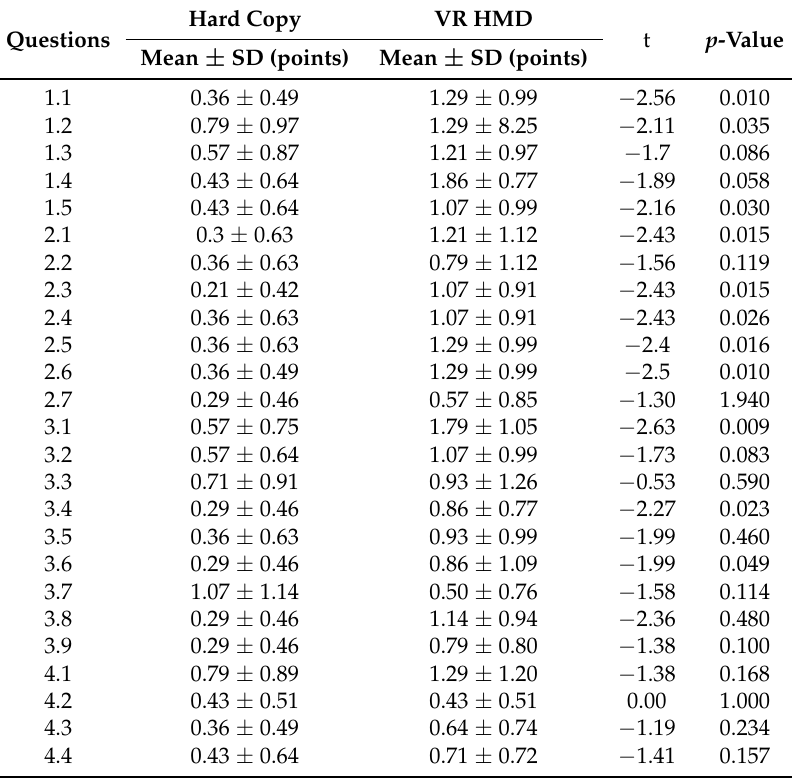
Table 4. Subjective symptom